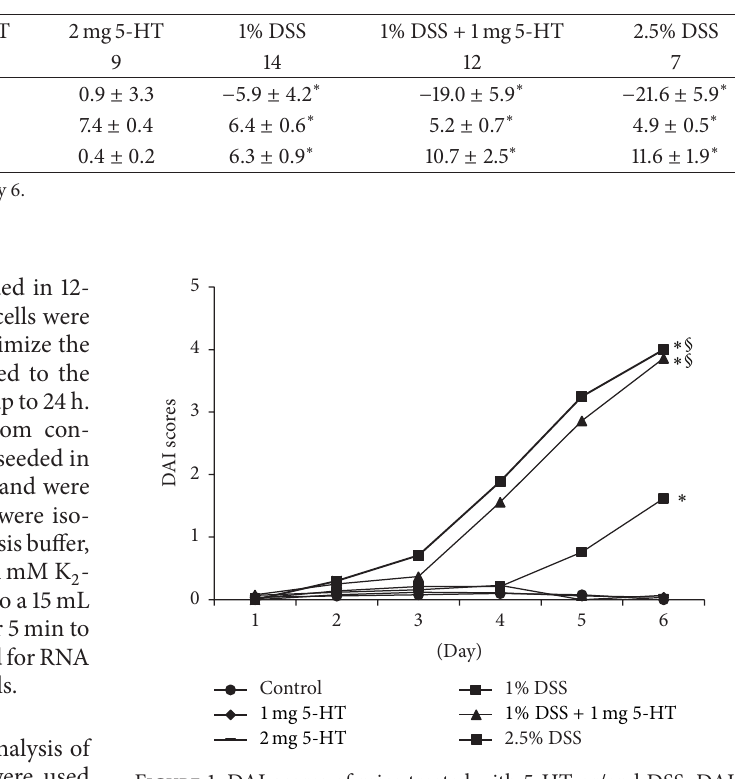
Figure 1: DAI scores of mice treated with 5-HT or/and DSS. DAI scoreswereanalyzedinsixgroupsofmice.Thecontrolgroup( 𝑛 = 8 ) and those receiving 1.0mg/kg ( 𝑛 = 9 ) or 2.0 mg/kg 5-HT ( 𝑛 = 9 ) had low levels of DAI. The group treated with 1.0% DSS ( 𝑛 = 14 ) had elevated DAI scores. Groups receiving 1.0% DSS plus 1.0 mg/kg 5-HT ( 𝑛 = 12 ) and 2.5% DSS ( 𝑛 = 7 ) had further increased DAI scores. Multiple comparisons among groups were done. ∗ 𝑃 < 0.05 versus mice in control, 1.0 mg/kg, or 2.0 mg/kg group. § 𝑃 < 0.05 versus mice 1% DSS